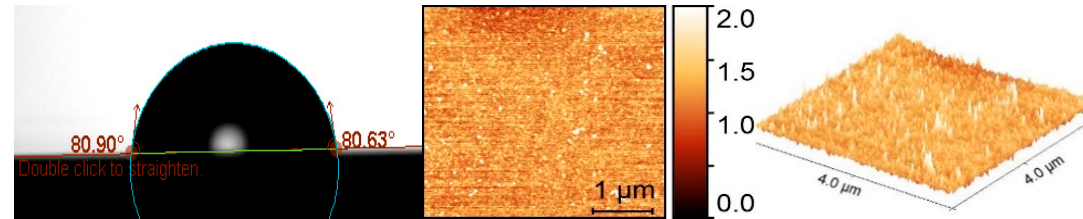
Figure 4. ( Left ) WCA test confirming the hydrophobicity increase of the surface. ( Right ) AFM topography characterization of the silanized SOI